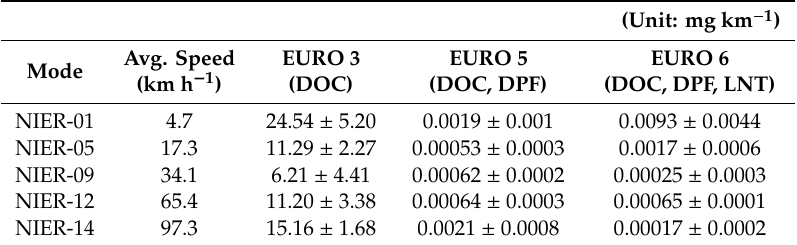
Figure 8. ( a ) Results of BC emission of EURO 3, 5, and 6 on five different NIER modes. ( b ) BC Emission from EURO 3 on CVS-75 mode, and EURO 4, 5, and 6 on NEDC mode. Table 6. BC emission of EURO 3, 5, and 6 vehicles during NIER cycle tests.